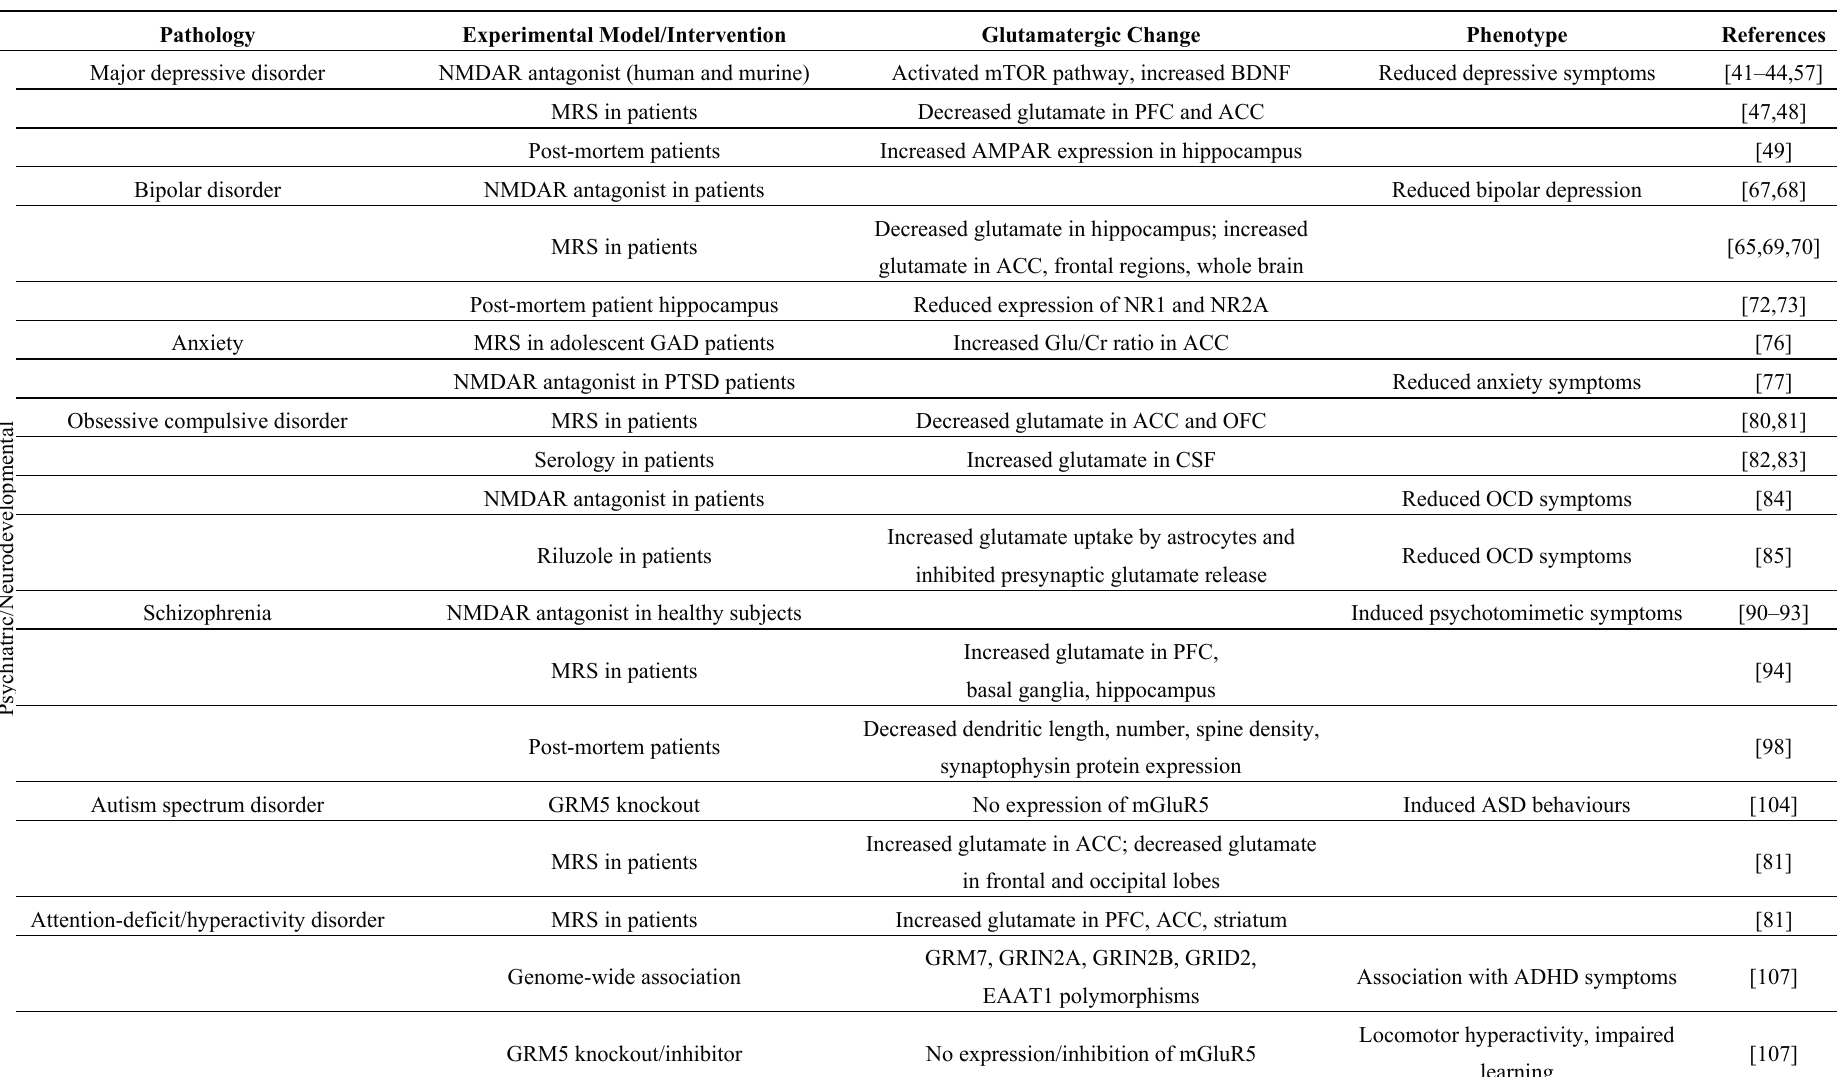
Table 1. Glutamate dysregulation in clinical and animal models of psychiatric, neurodevelopmental, and neurodegenerative